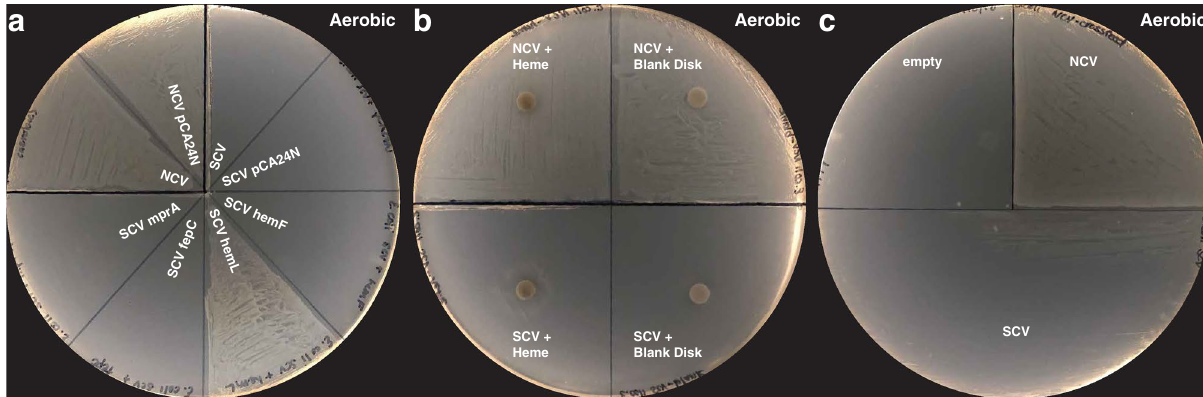
Figure 2. Heme biosynthesis lesion as cause of small colony phenotype in Escherichia coli isolated from urinary tract infection. Genomic sequencing of the paired NCV and SCV isolates revealed genomic lesions in fepC , hemF , hemL , and mprA . ( a ) Only genetic rescue with hemL rescued normal growth from the Escherichia coli SCV. ( b ) Chemical rescue with heme partially restored normal growth in Escherichia coli SCV. ( c ) Cross-feeding from Escherichia coli NCV partially restores growth of SCV, consistent with a diffusible factor required for growth. All plates in this figure were incubated under aerobic conditions.